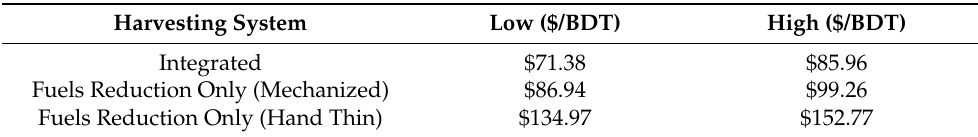
Table 9. Potential prices for delivered biomass at Crescent Mills, including a 30% markup that considers contractor profit, overhead, and